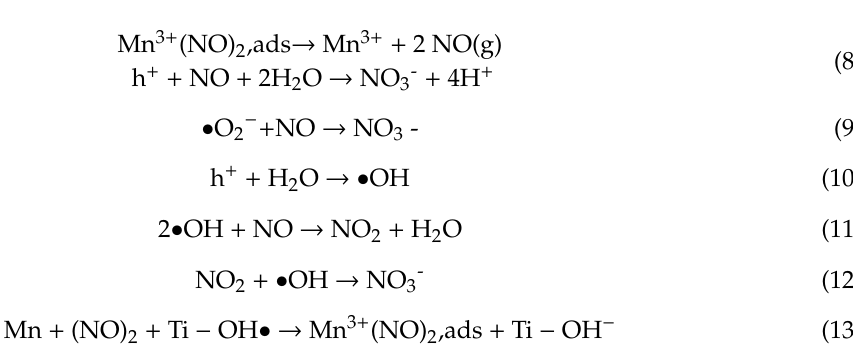
Figure S1: FE-SEM images of TP(G-Mn1) (b) TP(G-Mn2) and (c) TP(G-Mn3); Figure S2: TEM images of a) T(G-Mn1)(550) NW, b) T(G-Mn2)(550) NW, c) T(G-Mn3)(550) NW, d) T(G-Mn1)(800) NW, e) a) T(G-Mn2)(800) NW and f) T(G-Mn1)(800) NW; Figure S3. Core level XPS spectrum of A) T(G-Mn1)(550) NW, T(G-Mn2)(550) NW, and T(G-Mn3)(550) NW, and B) T(G-Mn1)(800) NW, T(G-Mn2)(800) NW and T(G-Mn1)(800) NW. Figure S4. Narrow scan XPS spectrum of Ti 2p, O1s and Mn 3d region for A)T(G-Mn1)(550) NW, T(G-Mn2)(550) NW, and T(G-Mn3)(550) NW. Figure S5. Narrow scan XPS spectrum of Ti2p, O1s and Mn 3d region for B) T(G-Mn1)(800) NW,T(G-Mn2)(800)NWandT(G-Mn1)(800) NW.FigureS6. RamanspectrumofT(G-Mn1)(550)NW,T(G-Mn2)(550) NW and T(G-Mn3)(550) NW. Figure S7. Raman spectrum of T(G-Mn1)(800) NW, T(G-Mn2)(800) NW and T(G-Mn3)(800) NW. Figure S8. UV-Visible di ff use reflectance spectrum of A) T(G-Mn1)(550) NW,